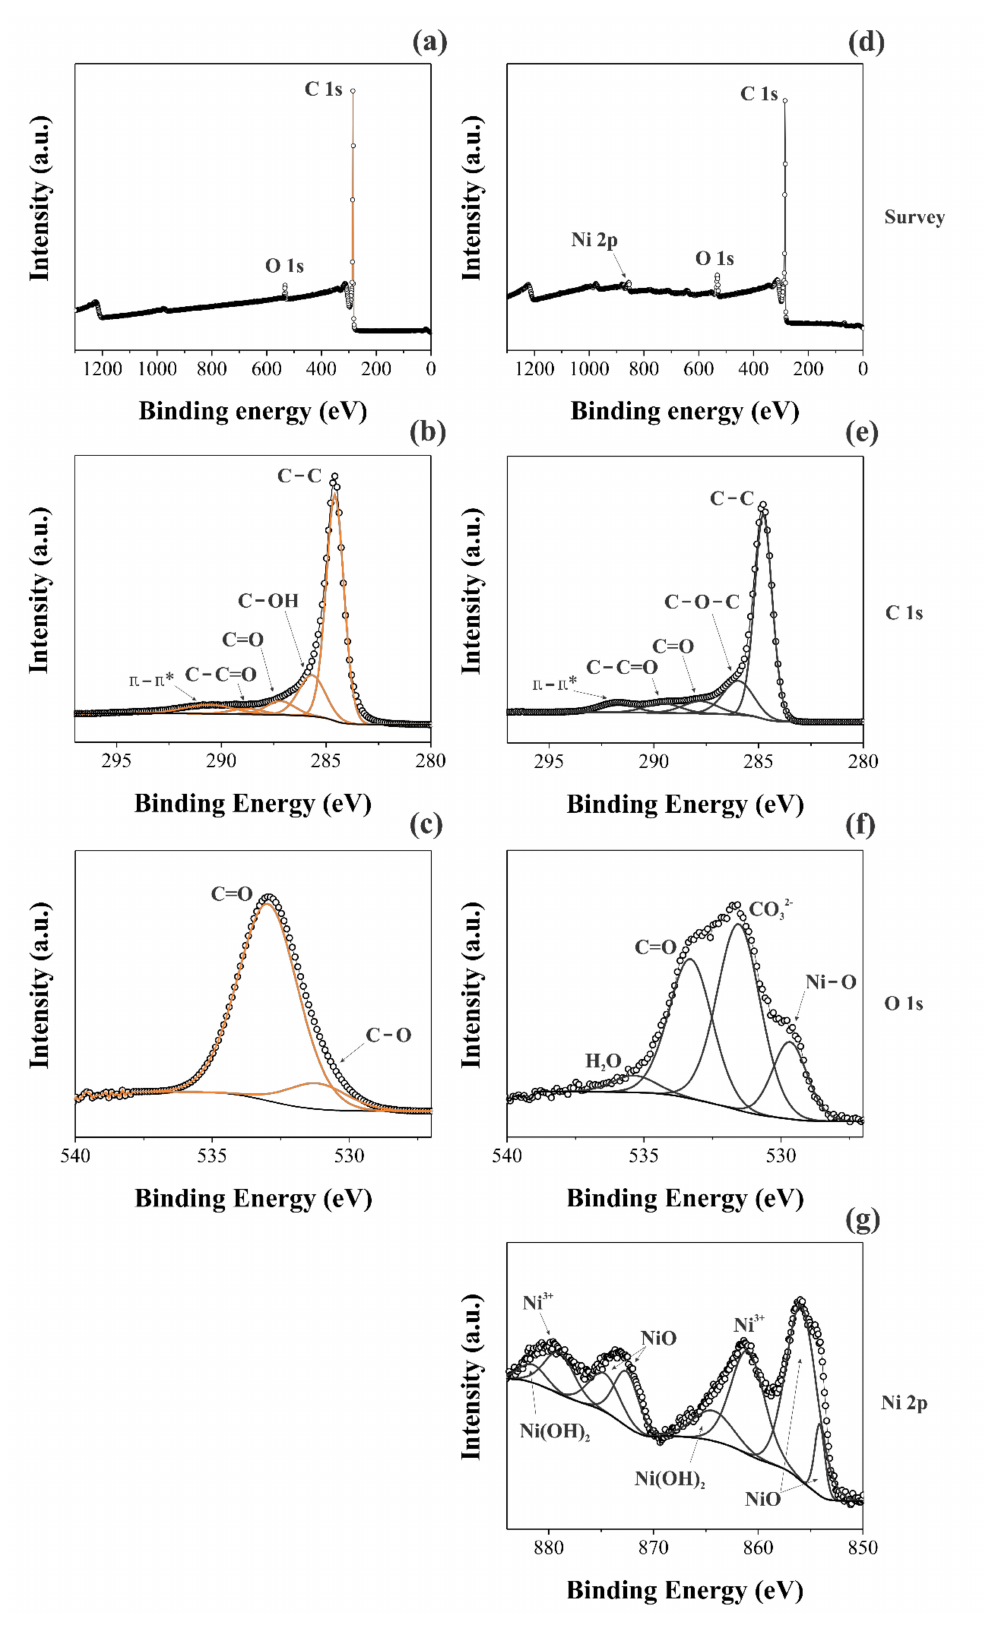
Figure 3. XPS spectra took for the CNFs ( a–c ) and NiO@CNFs ( d–g )